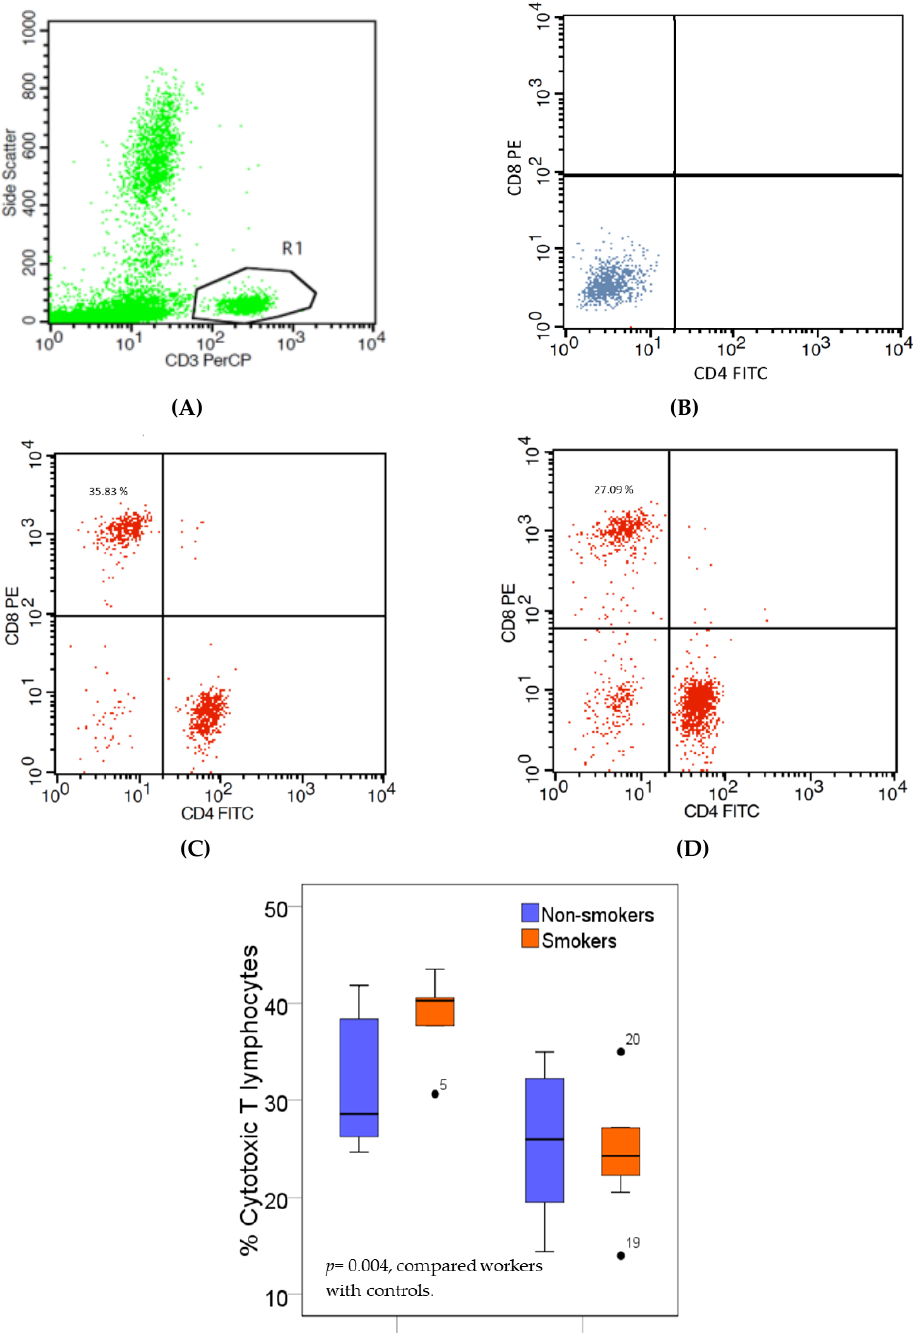
Figure 2. Effects of high Pb exposure on the percentage of cytotoxic T lymphocytes. The flow cytometry strategies (dot plots) show side scatter vs. CD3 (PerCP) ( A ), isotype control stained ( B ), the cytotoxic T (Tc) lymphocytes in one control subject ( C ), and one Pb-exposed worker ( D ). Boxplots compare percentages of Tc lymphocytes in controls versus workers, non-smokers, and smokers included ( E ). Outliers were the data points below or above 1.5× interquartile range. The p -value was derived from the Mann–Whitney U test, in which outliers were included.